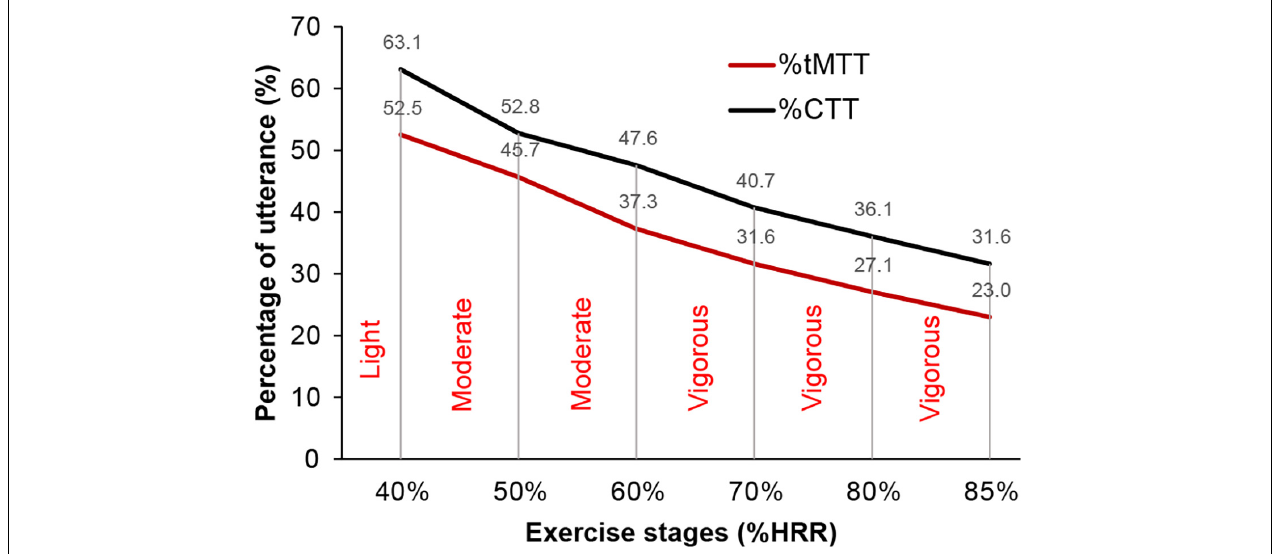
FIGURE 5 | The negative gradient of relative scores (i.e.,%tMTT and %CTT) and exercise stages (%HRR). Intensities of exercise are categorized from light, moderate, and vigorous.